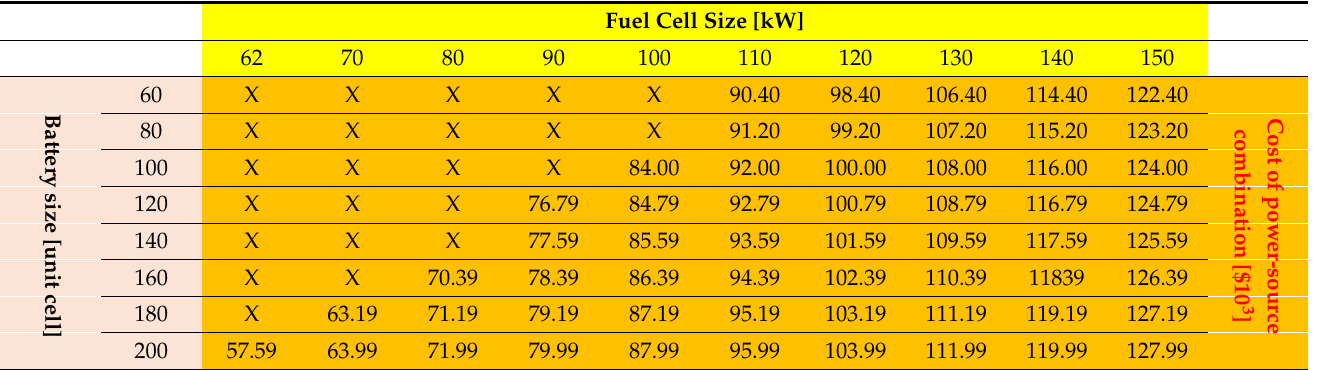
Table 2. The cost of different power-source